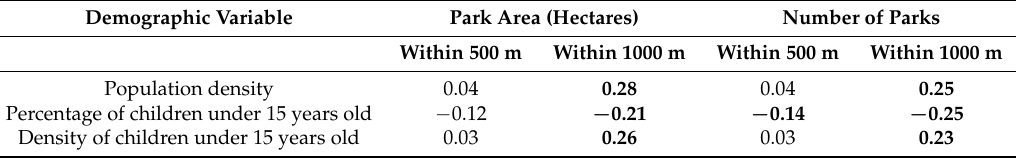
Table 6. Spearman correlations between number of parks and number of hectares (in proximity areas of 500 m and 1000 m) and demographic variables, by ward.